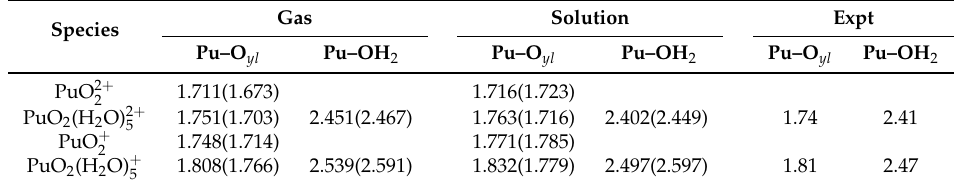
Table 1. The calculated bonding lengths (Å) of bare plutonyl (VI) and Plutonyl (VI) aquo species calculated at B3LYP/SARC-ZORA level of theory. The structural parameters calculated with B3LYP/SDD are given in the